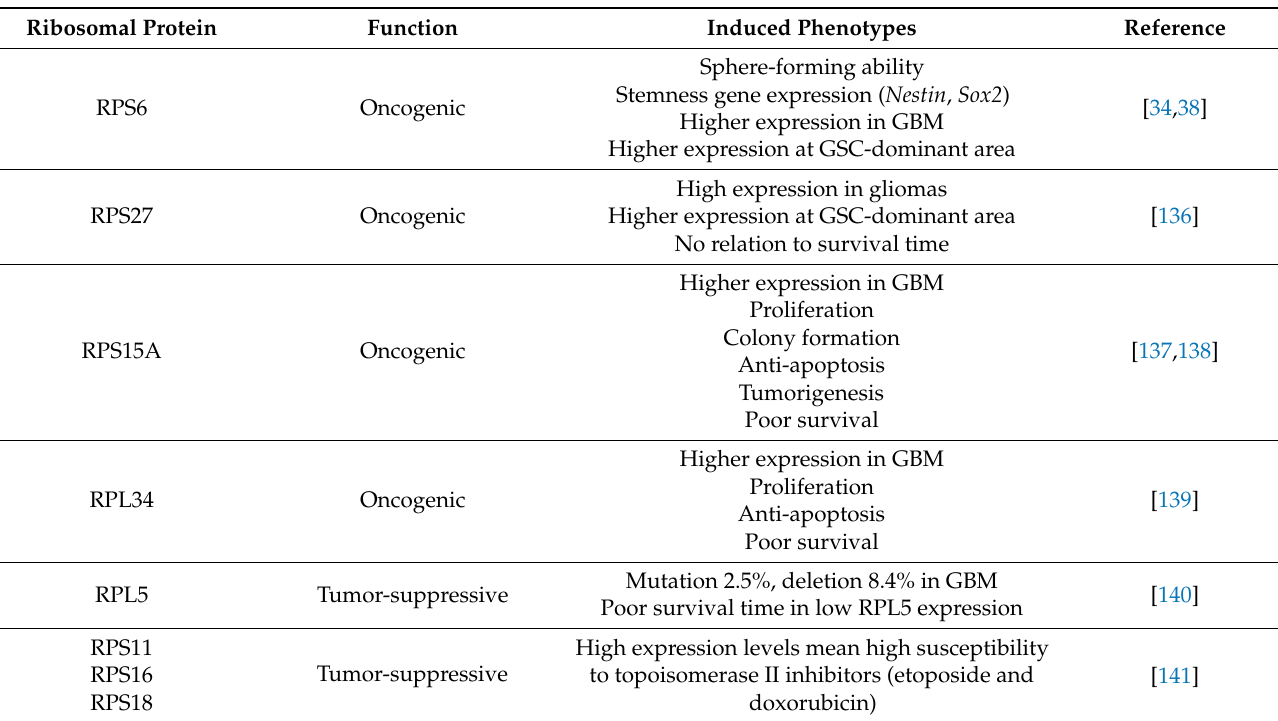
Table 1. Ribosomal protein in